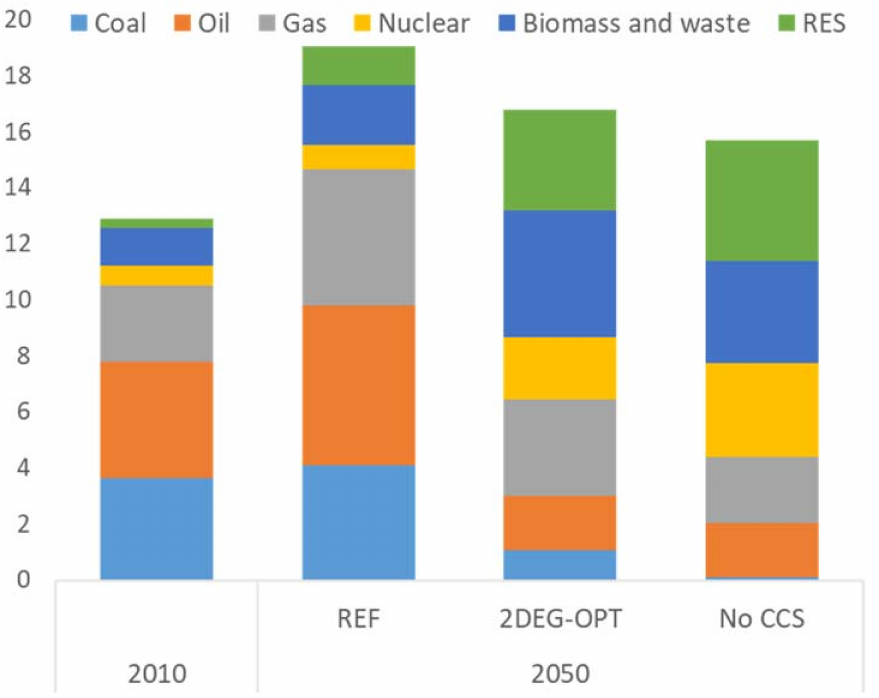
Figure 4. Global primary energy production by fuel in alternative scenarios (in Gtoe- Giga tonnes of oil